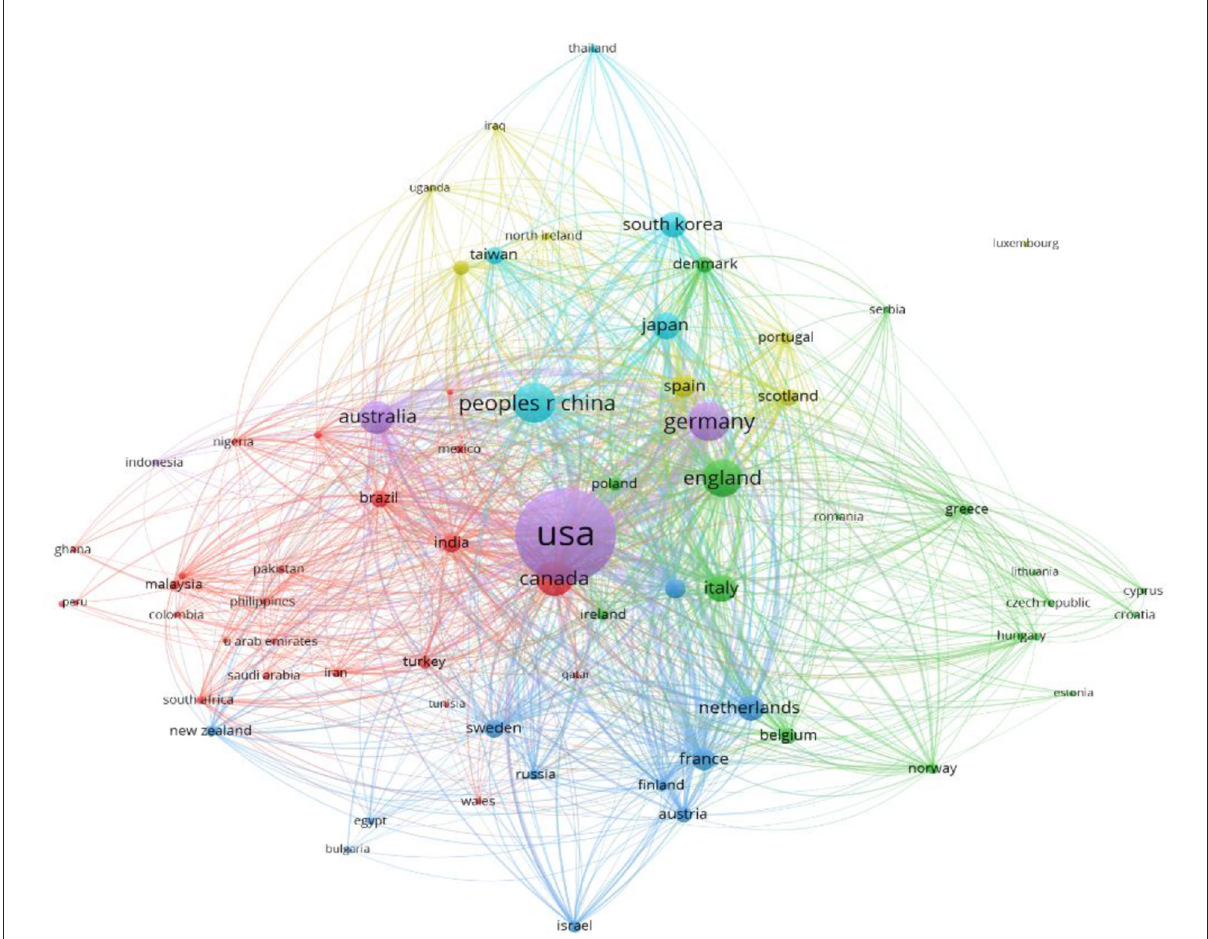
FIGURE3 The strength of the collaboration link between each productive/involved country with more than 20